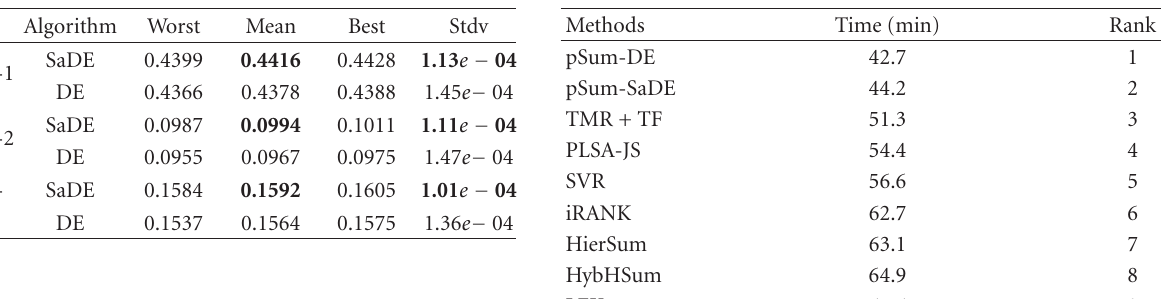
Table 4: Comparison pSum-SaDE with pSum-DE. Table 5: Comparison of the methods on time